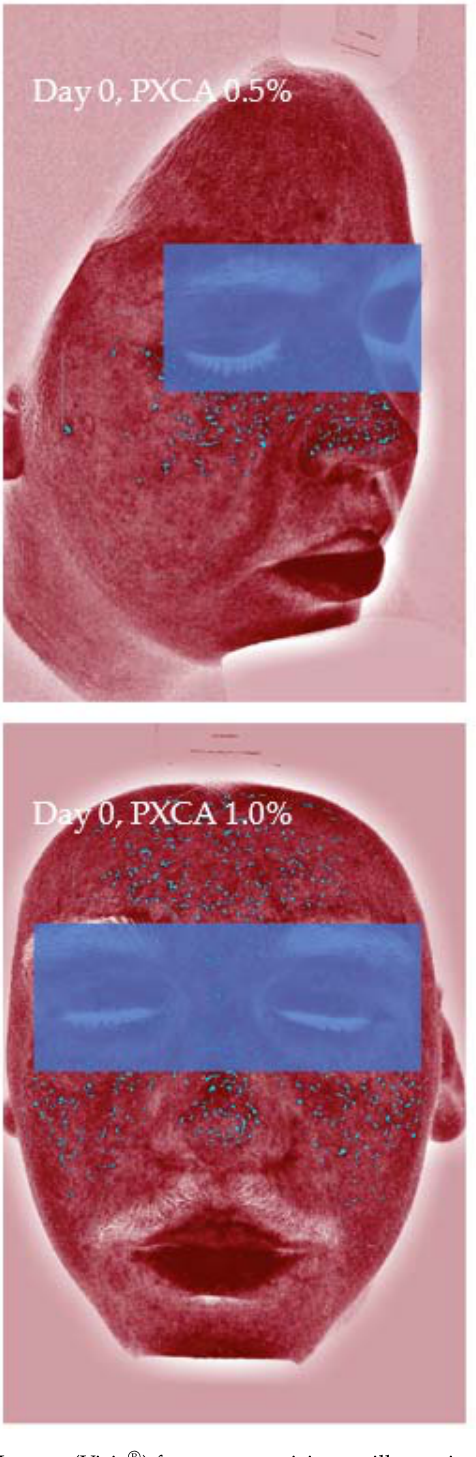
Figure 6. Images (Visia ® ) from two participants illustrating the reduction in inflammatory lesions after 28 days of treatment with PXCA 0.5% and 1.0%.